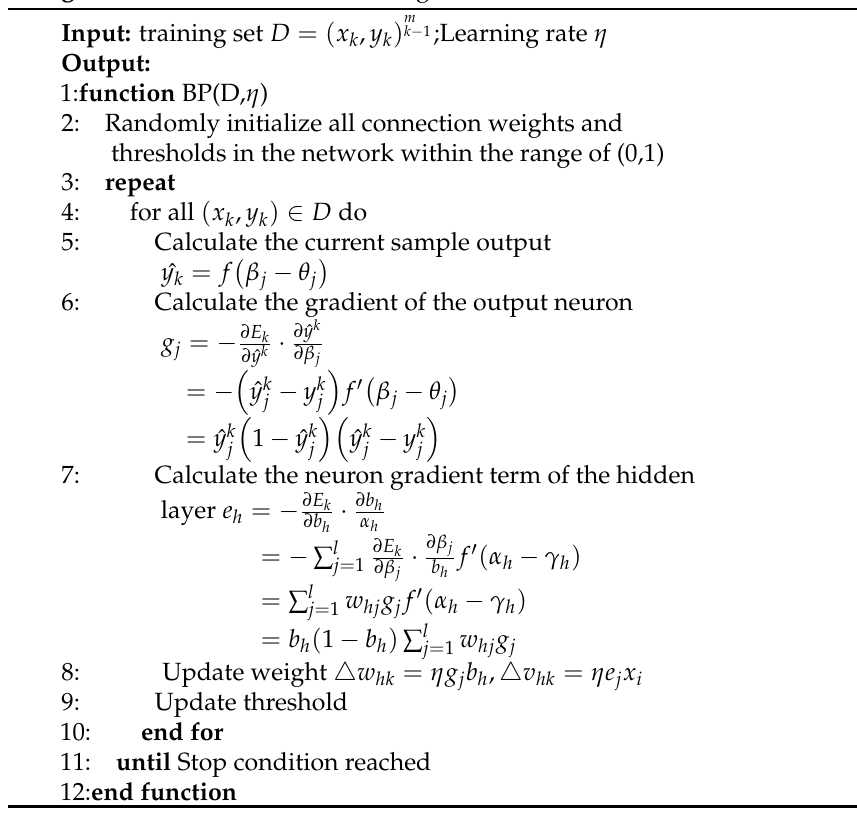
Algorithm 1: BP neural network